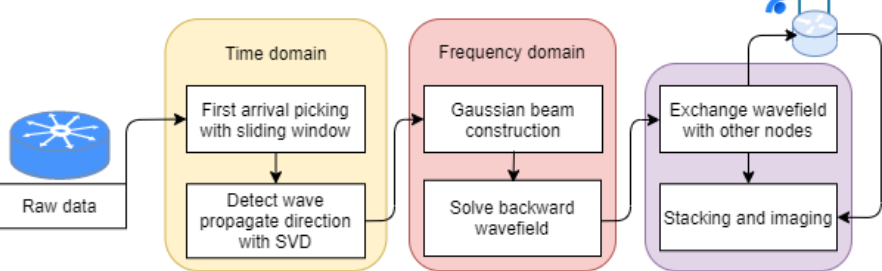
Figure 6. Workflow for source localization on a node in a distributed sensor network system.